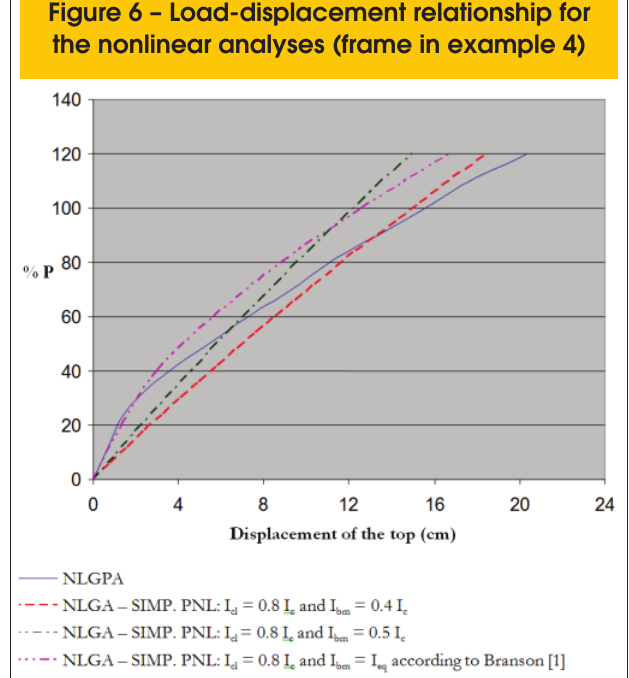
Figure 6 – Load-displacement relationship